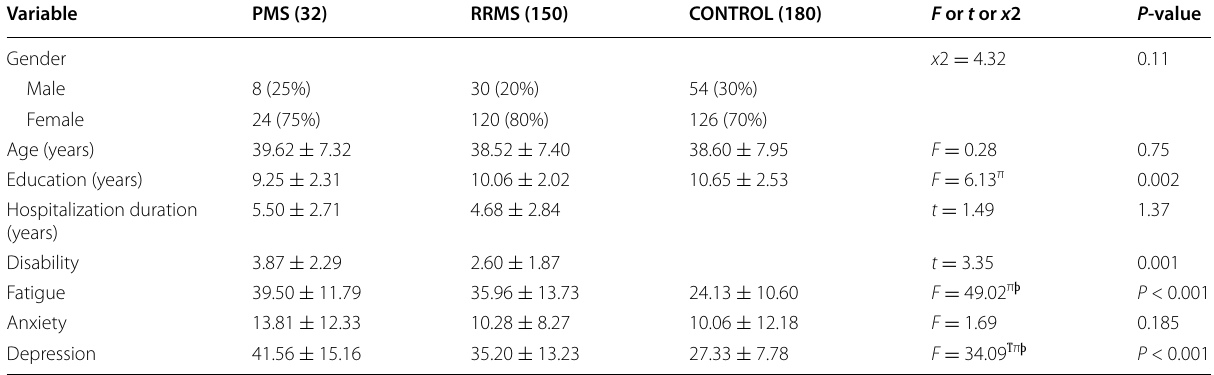
Table 1 The demographic and clinical characteristics of